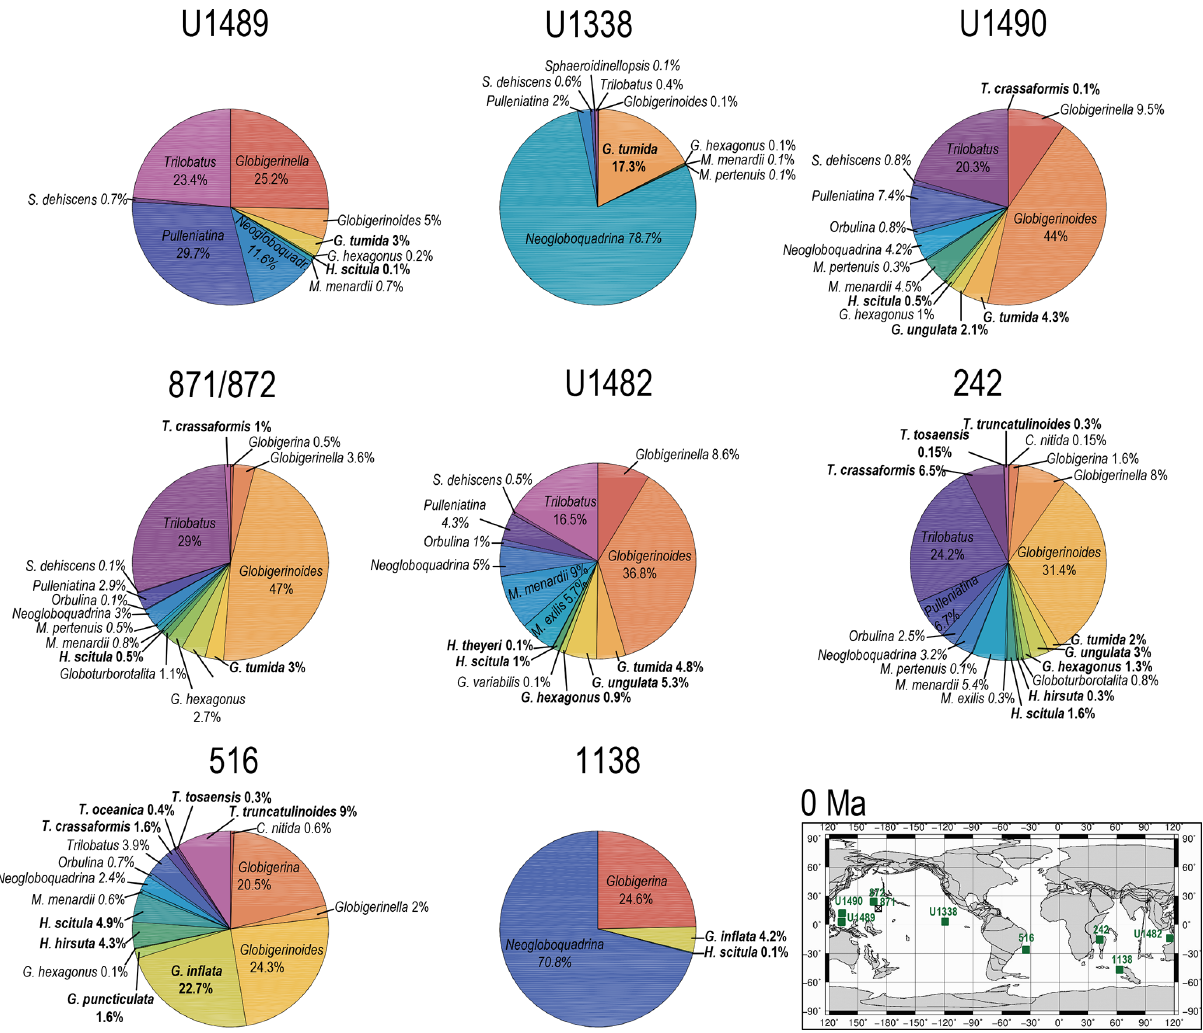
Figure 11. Abundance and biogeography of twilight zone planktonic foraminiferal species at 0Ma. In the pie charts, twilight zone planktonic foraminiferal species are in bold. Sites where twilight zone planktonic foraminifera were found are highlighted in green in the maps. The crossed square symbols in the maps indicate that the time interval of interest was not recovered for a given site. Continental configuration follows the Ocean Drilling Stratigraphic Network (GEOMAR; Kiel,